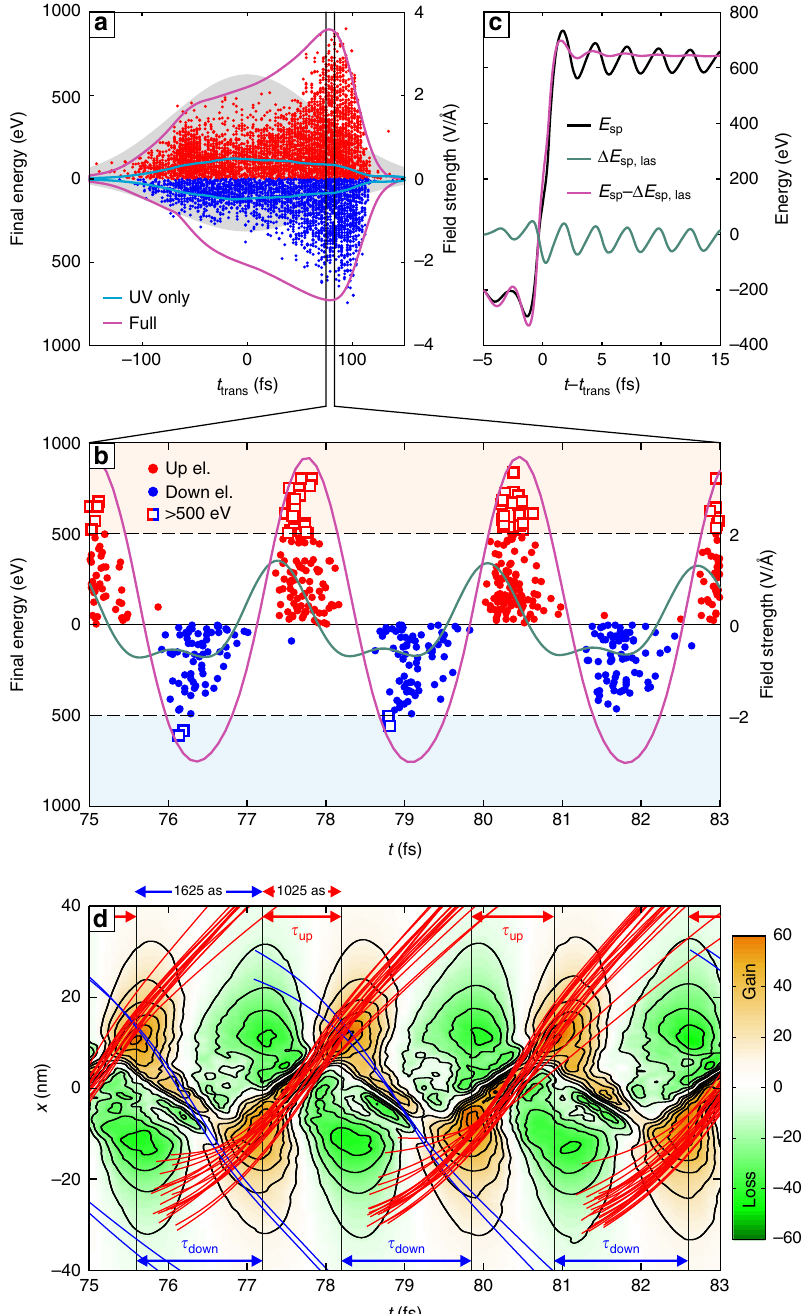
Fig. 2 Molecular dynamics simulation of the asymmetric electron emission. a Scatter plot of fi nal kinetic energies and emission times ( E fi nal , t trans ) of electrons emitted in upward (red) and downward (blue) direction from the simulation run for φ = 0 in Fig. 1c. The envelopes of the laser fi eld and the indicated polarization fi eld components inside the cluster are shown as gray area and solid curves, respectively (only components along x -axis, right scale). The time axis is centered at the peak of the ω /2 ω probe pulse. b Cycle-resolved analysis of the electron emission times and energies (symbols, left scale) in the resonance region. Solid curves show the corresponding evolutions of the laser fi eld (green) and the polarization fi eld (magenta) inside the cluster (right scale). Fast electrons ( E fi nal > 500 eV, marked with boxes) are selected for further analysis. c Evolution of the single-particle energy E sp during the fi nal transit (black) resulting from averaging over the selected trajectories. Subtracting the direct laser absorption Δ E plasmonic contribution (magenta). d Projected trajectories x i ( t ) of the selected electrons and spatiotemporal plasmonic gain map ∂ ∂ t V x ; t ð Þ sampled on the polarization axis. Dark orange regions mark high-gain points and horizontal arrows indicate optimal gate times for forward rescattering in upward and downward direction, respectively. At the time of the resonance, the cluster has expanded to a radius R ≈ 13